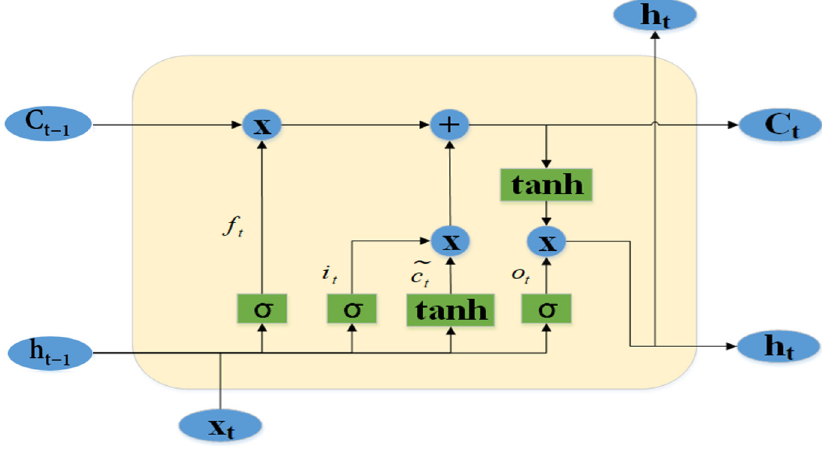
Figure 2. LSTM cell.